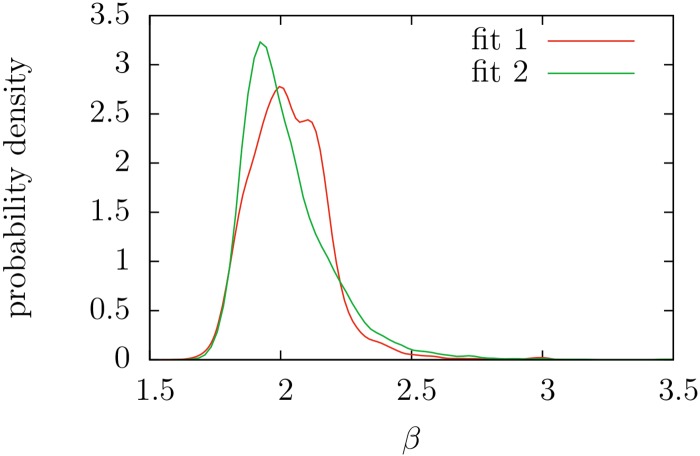
Estimation of the probability density of the Zipf’s exponent β for texts yielding p ≥ 0.05 in the fits of f1 and f2.Curves have been calculated from the histograms via normal kernel smoothing method as implemented in MatLab (ksdensity function). Estimated mean and standard deviation of β are 2.03 and 0.15 respectively for the fit of f1, and 2.02 and 0.17 for f2.